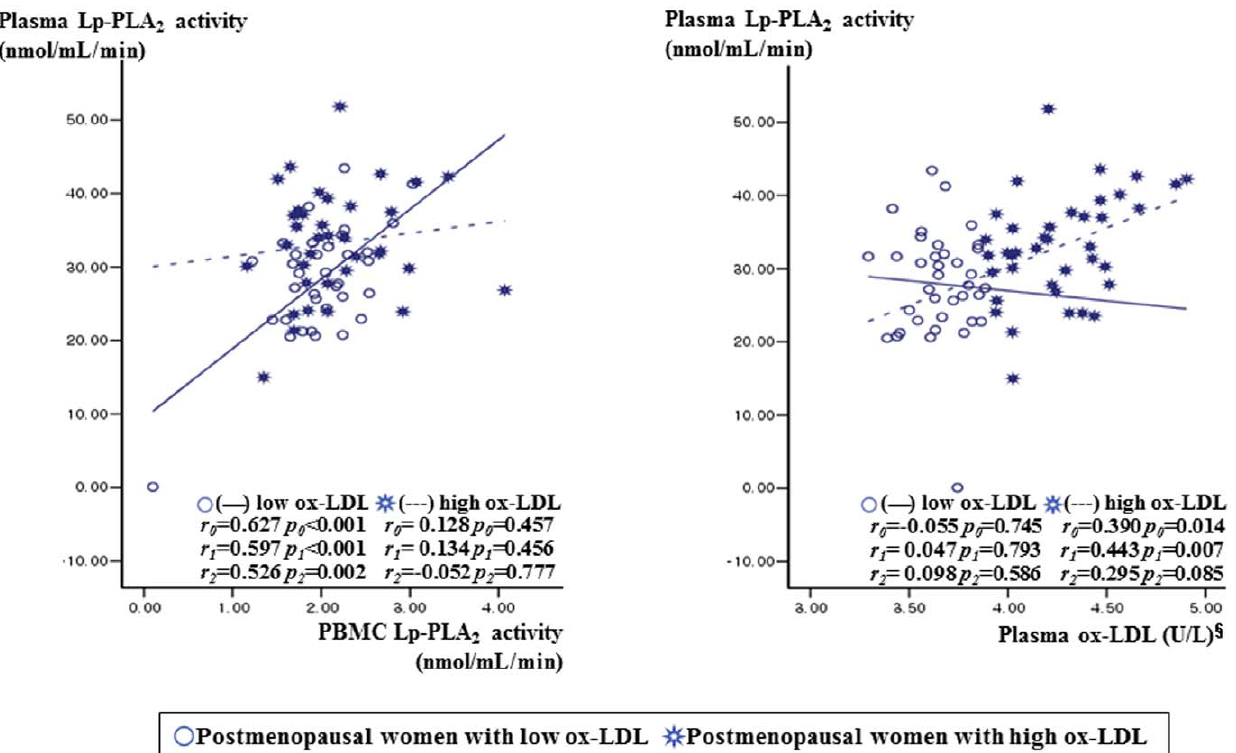
Figure 1. Relationship between Lp-PLA 2 activity from PBMCs or plasma ox-LDL and plasma Lp-PLA 2 activity according to plasma ox-LDL (below or above the median level of 48.715 U/L) in postmenopausal women. 1 tested by log-transformed. Tested by Pearson correlation ( r 0 ) or partial correlation analysis ( r 1 , r 2 ). r 0 : correlation coefficient, unadjusted. r 1 : correlation coefficient after adjusted for age, BMI, and alcohol consumption. r 2 : correlation coefficient after adjusted for age, BMI, alcohol consumption, and LDL-cholesterol. doi:10.1371/journal.pone.0029675.g001 PLoS ONE |